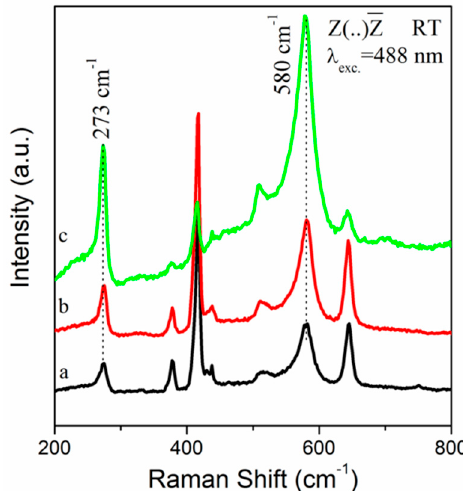
Figure 2. Room temperature Raman backscattering spectra for samples (a) A, (b) B, and (c) C.